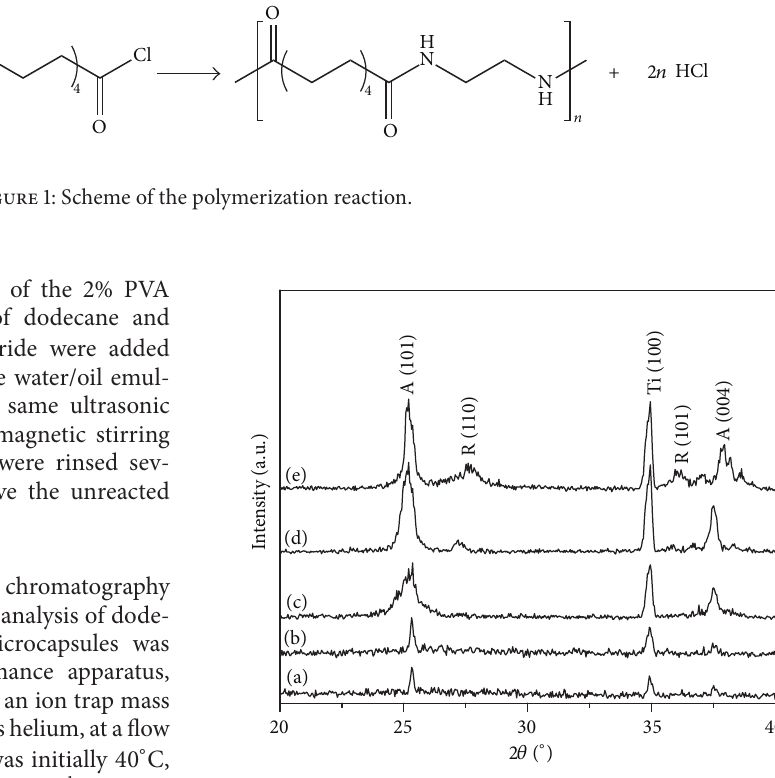
Figure 2: XRD patterns of the N-doped TiO 2 powders calcined at (a) room temperature (b) 300 ∘ C (c) 500 ∘ C, (d) 700 ∘ C, and (e) 800 ∘ C. A: anatase; R: